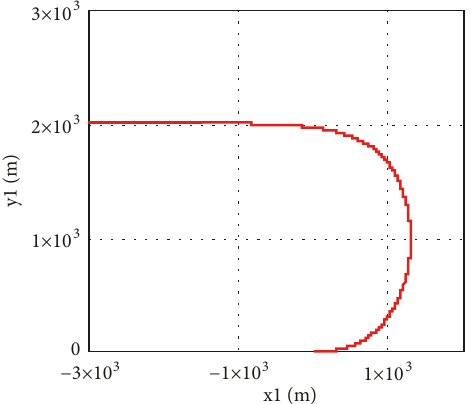
Figure 12: Vessel trajectory during rotation towards the return course for values 𝑧 ∗ 3 = 0.005𝑟𝑎𝑑 ⋅ 𝑠 −1 , 𝑧 ∗ 6 = 3.14𝑟𝑎𝑑 ; 𝑇 𝑢 = 2𝑠